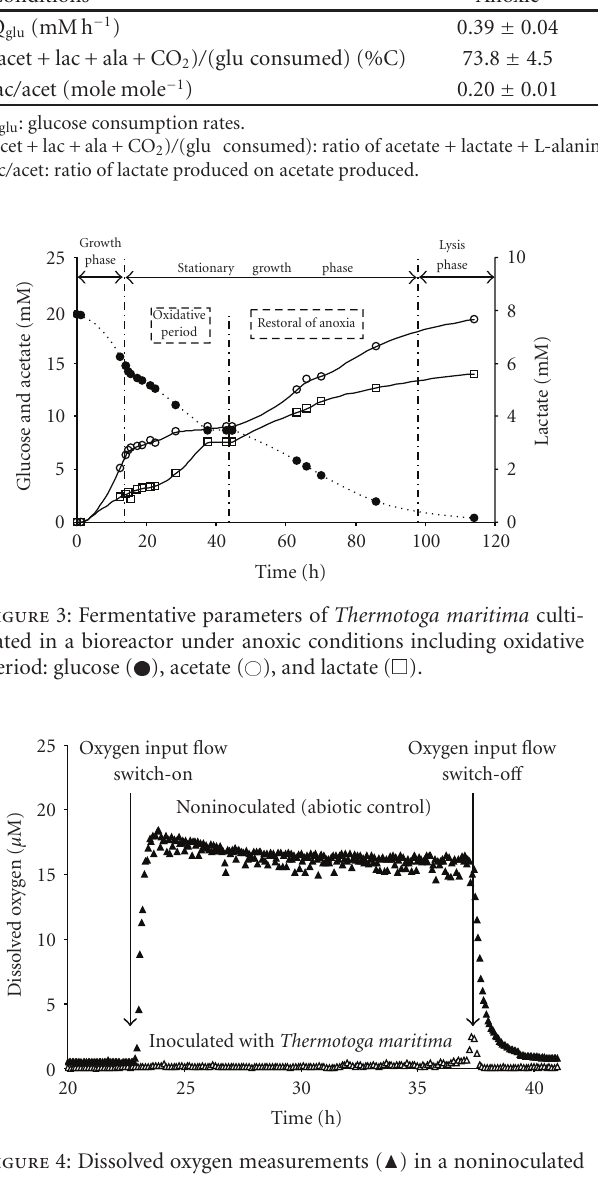
) in a noninoculated (cid:2)